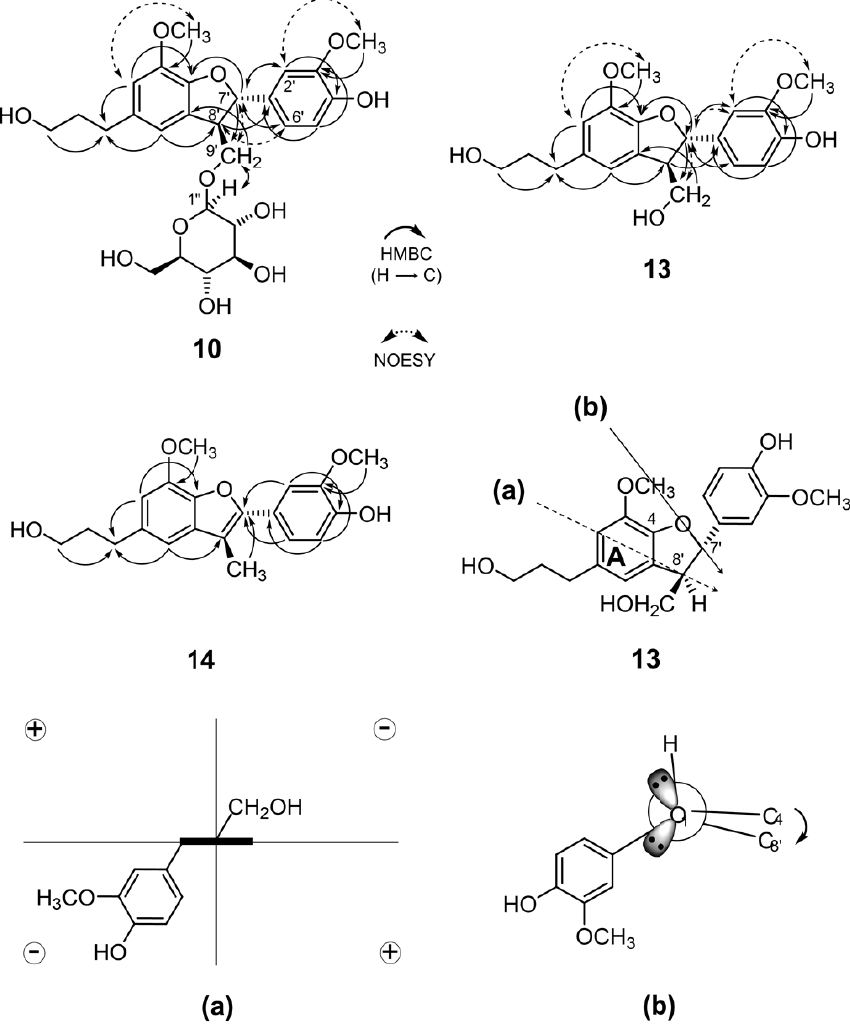
Figure 2 . The key HMBC and NOESY correlations for compound 10 , compound 13 and 14 chemi- cal structures, and projection for 1 L a ( a ) projection in the direction of the arrow, the wedge indi- cates the plane of the A-ring); and 1 L b ( b ) transition for 13 .